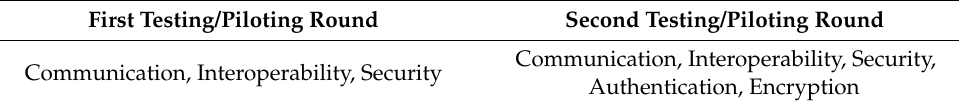
Table 3. FASTER architecture features scheduled to be tested on each piloting/testing